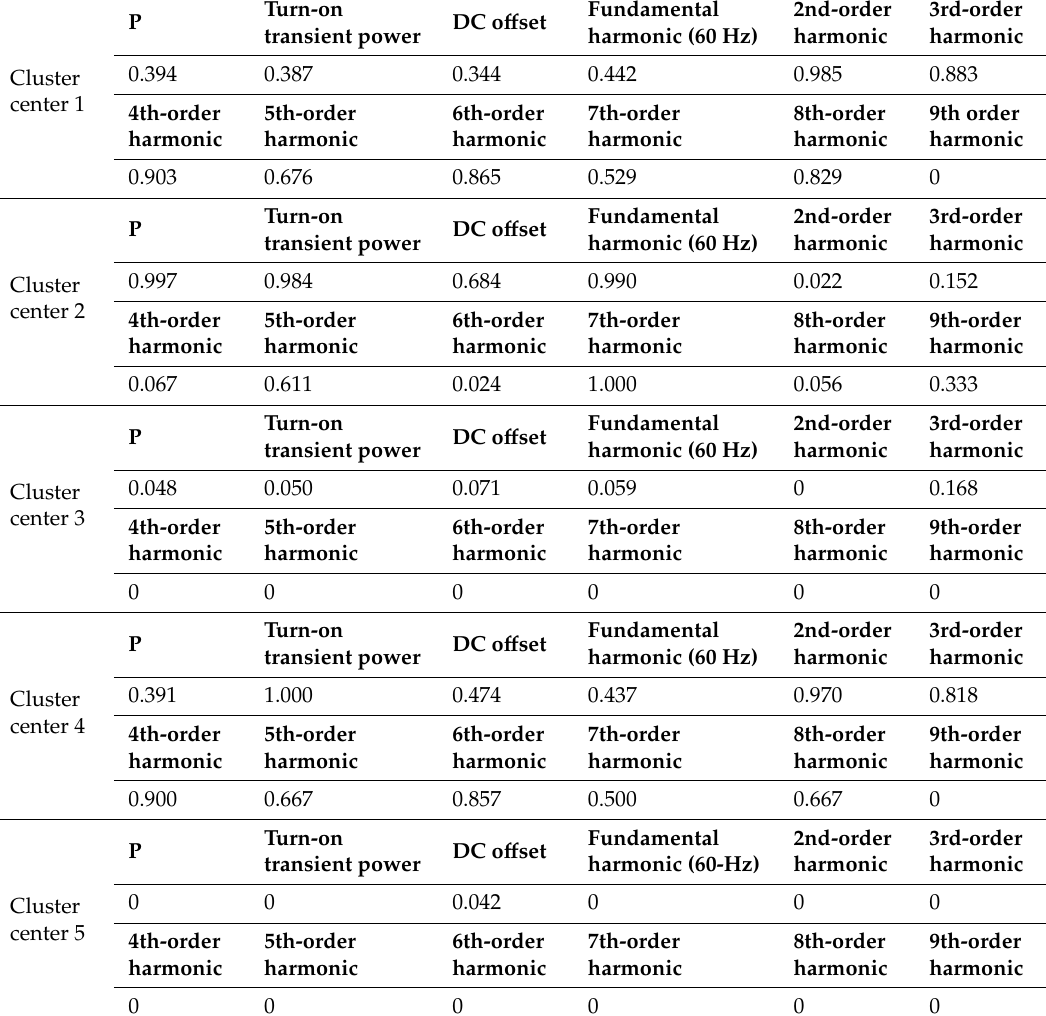
Table 5. Center parameters found through k-means clustering are used to characterize the RBF-ANN of Equation (1), where electrical feature data are normalized in this